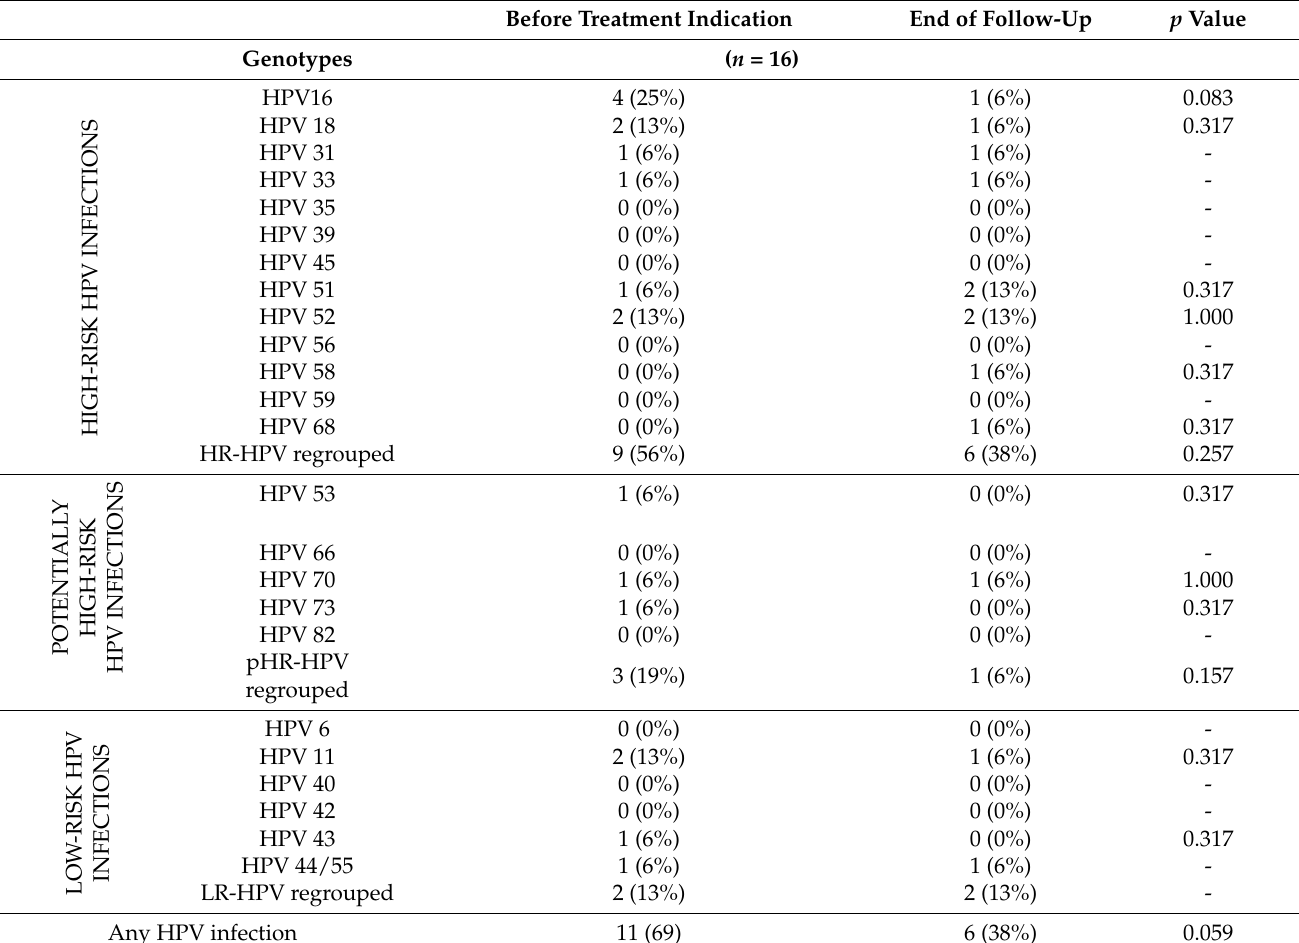
Table 3. Prevalence of HPV infection at the time of indication and by the end of the follow-up among women who did not receive treatment for cervical